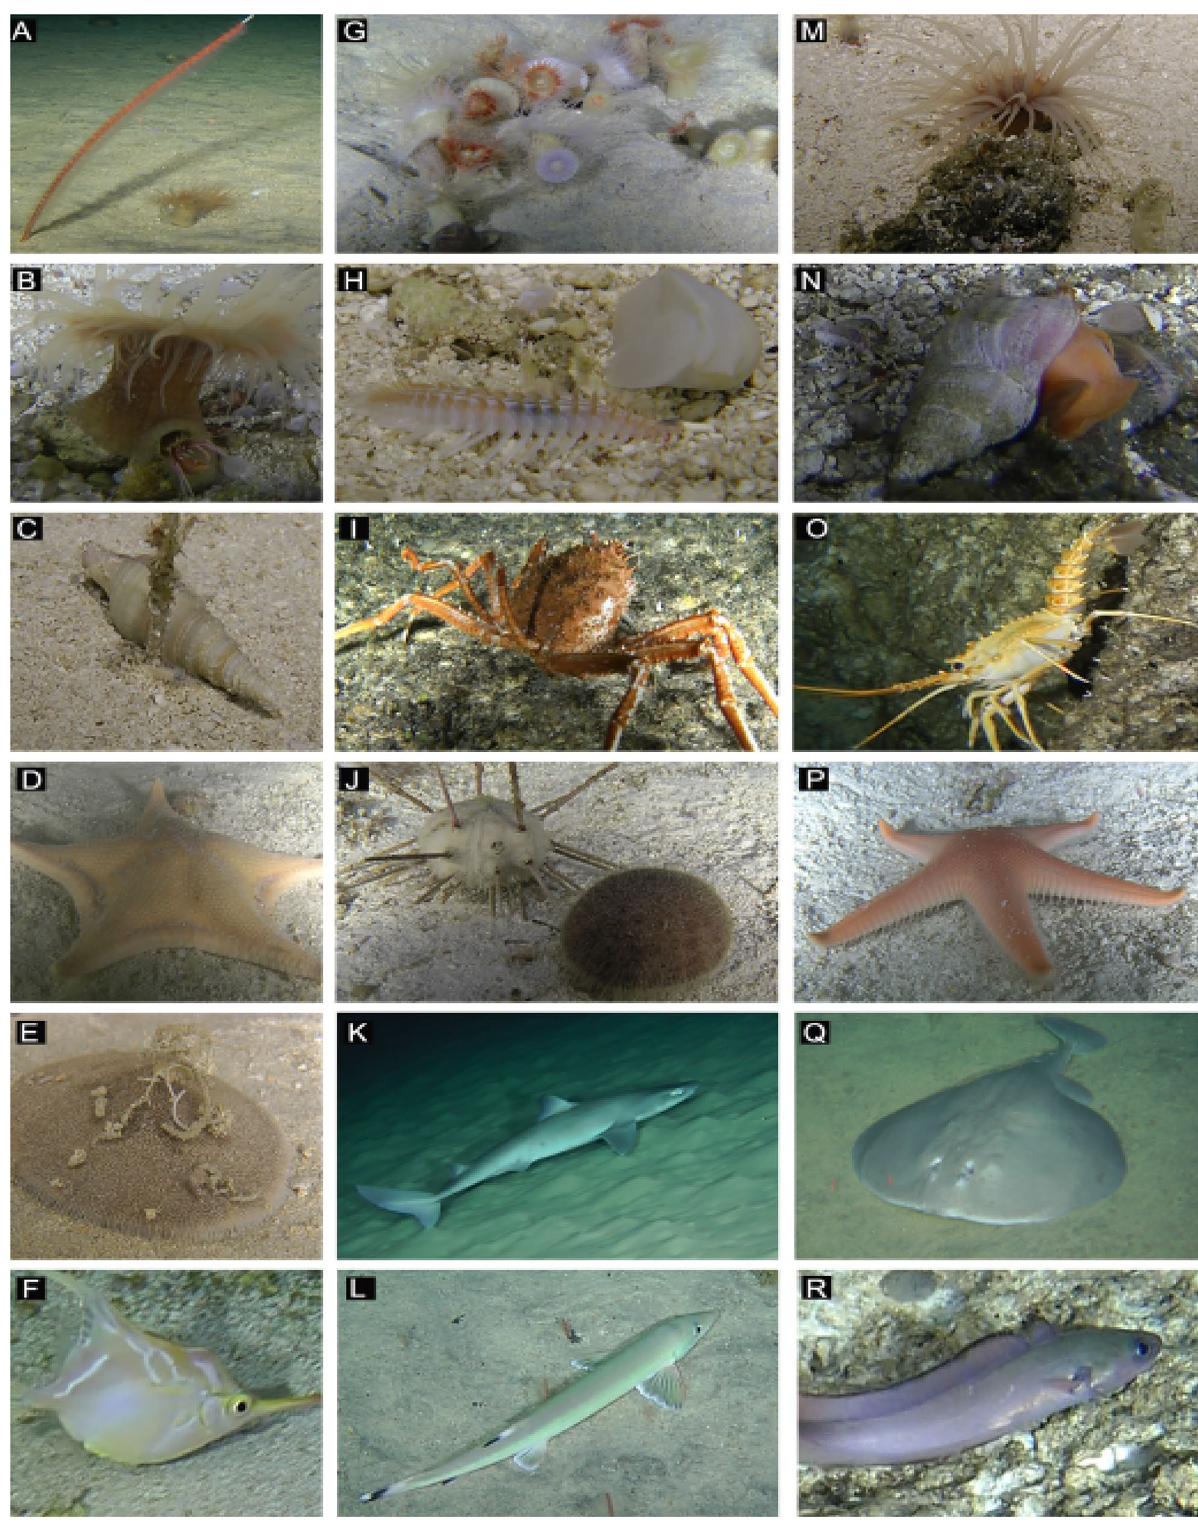
Figure 4. Representative OTUs observed at the upper slope of Desventuradas islands and seamounts within the Nazca-Desventuradas Marine Park. ( A ) Sea pen Protoptilum sp. and anemone Hormathia sp., ( B ) anemone ( Hormathia sp.) and hermit crab Paragiopagurus boletifer , ( C ) Cryptogemma praesignis , ( D ) Anthenoides sp., ( E ) Clypeaster isolatus , ( F ) Notopogon fernandezianus , ( G ) anemone colony Hormathia sp., ( H ) Chloeia sp., ( I ) Paromola rathbuni , ( J ) Stereocidaris nascaensis (left) and Scrippsechinus fisheri (right), ( K ) Squalus mitsukurii , ( L ) Gonorhynchus greyi , ( M ) tube anemone Ceriantharidae, ( N ) Chryseofusus kazdailisi , ( O ) Projasus bahamondei , ( P ) Pseudarchaster sp., ( Q ) Tetronarce sp., and ( R ) Lotella fernandeziana . Laser pointers, when visible, are 10 cm apart. Image credits: